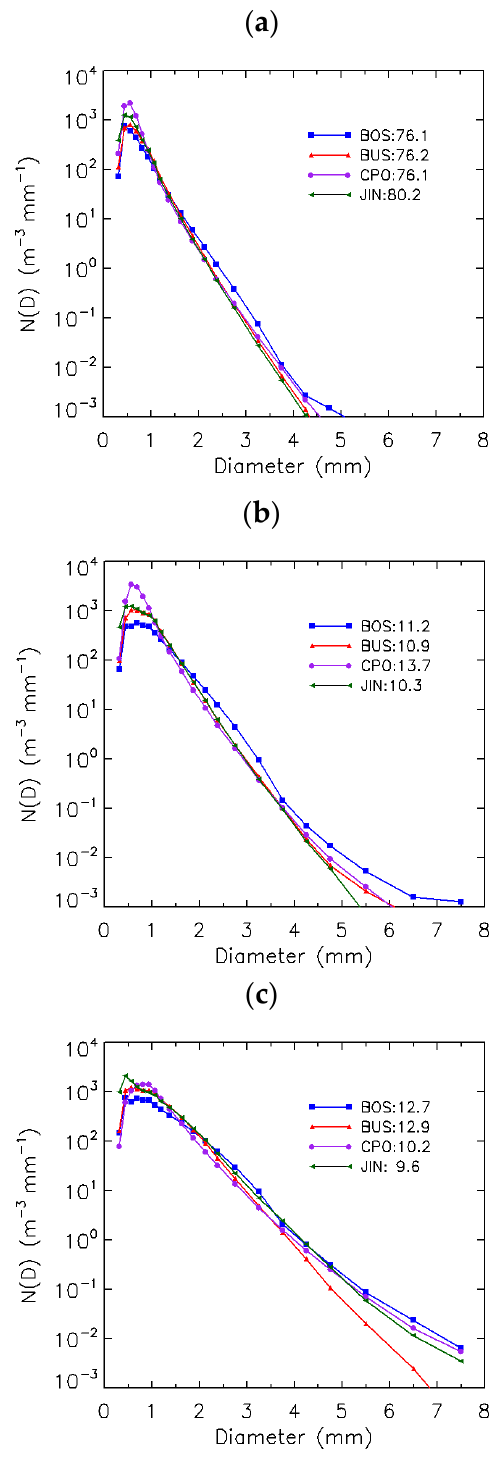
Figure 5. Average raindrop number concentration with diameter at four different sites with respect to rain rate ( a ) 0.1 < R < 5.0 mm h − 1 , ( b ) 5.0 < R < 10.0 mm h − 1 , and ( c ) 10.0 mm h − 1 < R. The rectangles in blue represent BOS, the triangles in red represent BUS, the circles in purple represent CPO, and the arrows in green represent the JIN site. The numbers in the legend represent the percentage of each rain rate.